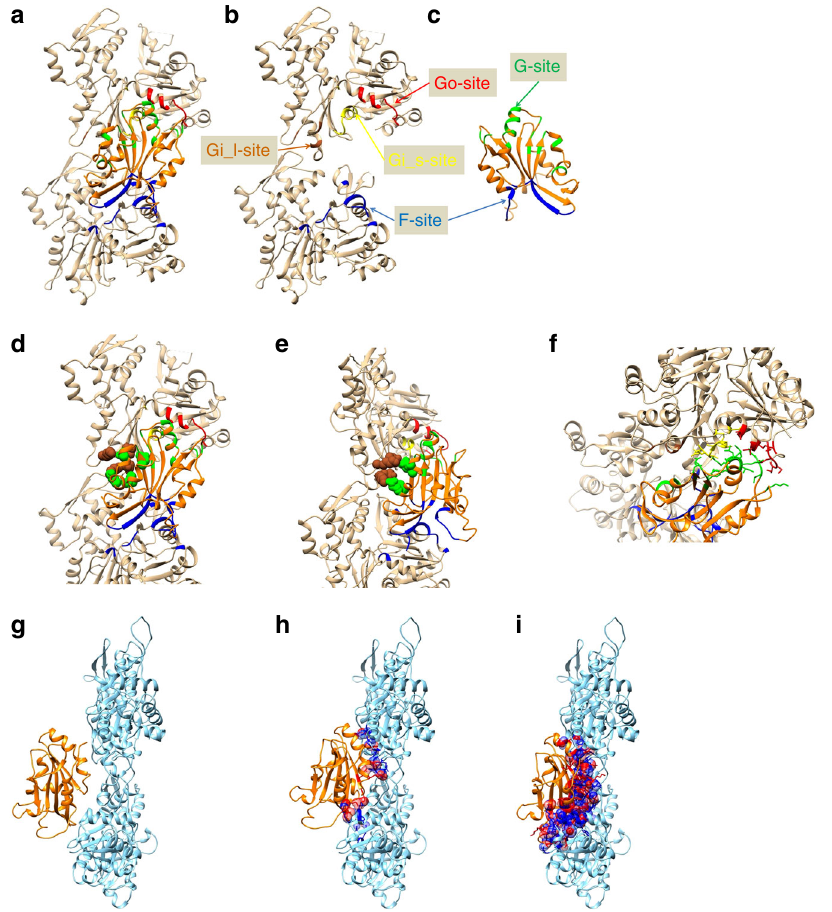
Fig. 4 Actin – co fi lin interactions. In a – e and g – i , the P-end is at the top. a – f Actin and co fi lin are presented in camel and orange, respectively. The F-site (Co fi lin-B-subunit interface), Go site (Co fi lin-SD1 of the P-subunit interface), Gi_l site (Co fi lin-ID of the P-subunit interface with long-range interactions) and Gi_s-sites (Co fi lin-ID of the P-subunit interface which is not included in the Gi_l site) in the actin subunits are shown in blue, red, brown and yellow, respectively. In co fi lin, residues forming the F-sites and G-sites are represented in blue and green, respectively. a Two actin subunits and the bound co fi lin are presented. b Co fi lin was removed from a . c Co fi lin in a is rotated by 180°. d Residues contributing to the Gi_l-site are shown as a space- fi lling model. e A 50° rotation of d . f Residues within the Gi_s-sites and Go-sites are presented as sticks in an end-on view of the 111 – 119 helix of co fi lin. g – i Models showing the steric hindrance expected when co fi lin binds to F-actin. Colliding atoms on both actin and co fi lin are represented as a space- fi lling model in blue and red, respectively. The other atoms of the residues containing the colliding atoms are represented as a stick model. g A model of co fi lin bound to the actin fi lament through the F-site. No collisions occur. h A model of co fi lin bound through the Gi-site. i A model of co fi lin bound through the